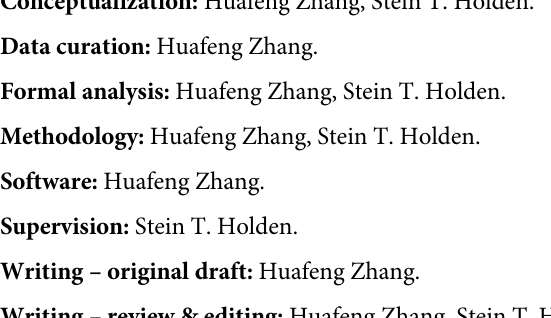
S1 Table. The sample size of children who have done the numeracy test by disability status and country. S2 Table. Regression results for estimating the determinant factors of each disability type. S3 Table. Sample characteristics. S4 Table. Regressions on the mean numeracy score with age dummy by countries (non-dis- abled children). S5 Table. Regression on the completed school